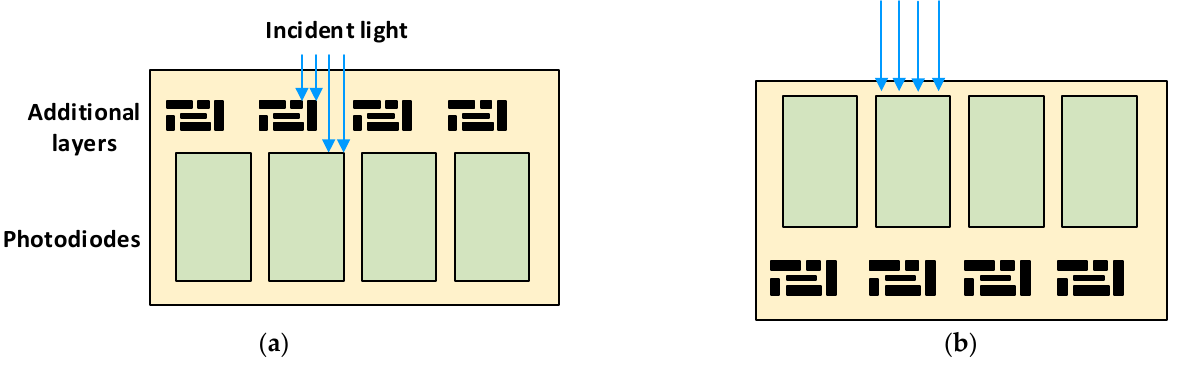
Pixel amplifier Figure 5. Schematics of a CMOS image sensor. Front-Illuminated versus Back-Illuminated Image Sensors The pixels include the photodiodes or light-to-charge conversion elements. The pix- els are interconnected with metal wires, forming a matrix so that incoming light can be spatially localized. In both CCD and CMOS image sensors, the size of the array of pixels influences the signal-to-noise ratio and the dynamic range of the sensor, which is related to the maxi- mum achievable signal divided by the noise of the camera, which contributes to the qual- ity of the image [68]. Back-illuminated image sensors are more sensitive than front-illuminated sensors be-